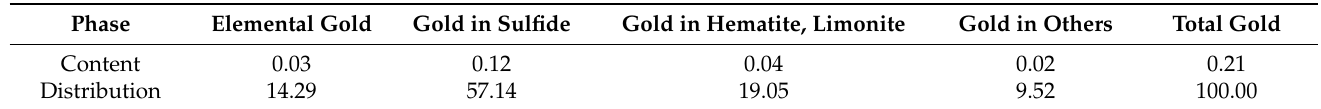
Table 2. Gold phase distribution of tailings samples from quartz vein-hosted gold deposits (mass fraction, %).